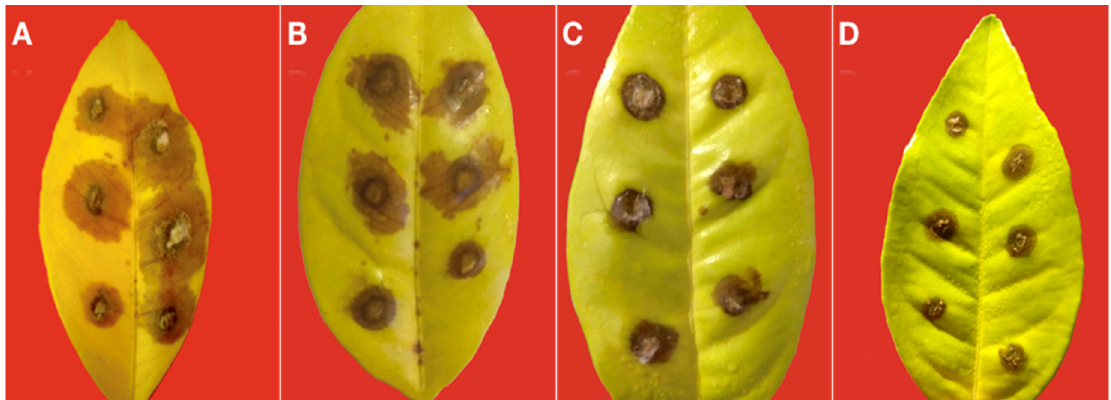
Figure 11. ( A ) Necrotic lesions induced by the heterologous Colletotrichum karstii isolate from camellia on wound inoculated young leaves of sweet orange ‘Navelina’ 5 d.p.i. ( B ) Necrotic lesions induced by the heterologous reference isolate of Colletotrichum acutatum from olive on wound inoculated young leaves of sweet orange ‘Navelina’ 5 d.p.i. ( C ) Necrotic lesions induced by an isolate of Colletotrichum karstii from citrus on wound inoculated young leaves of sweet orange ‘Moro’ 5 d.p.i. ( D ) Necrotic lesions induced by an isolate of Colletotrichum gloeosporioides from citrus on wound inoculated young leaves of sweet orange ‘Moro’ 5 d.p.i.